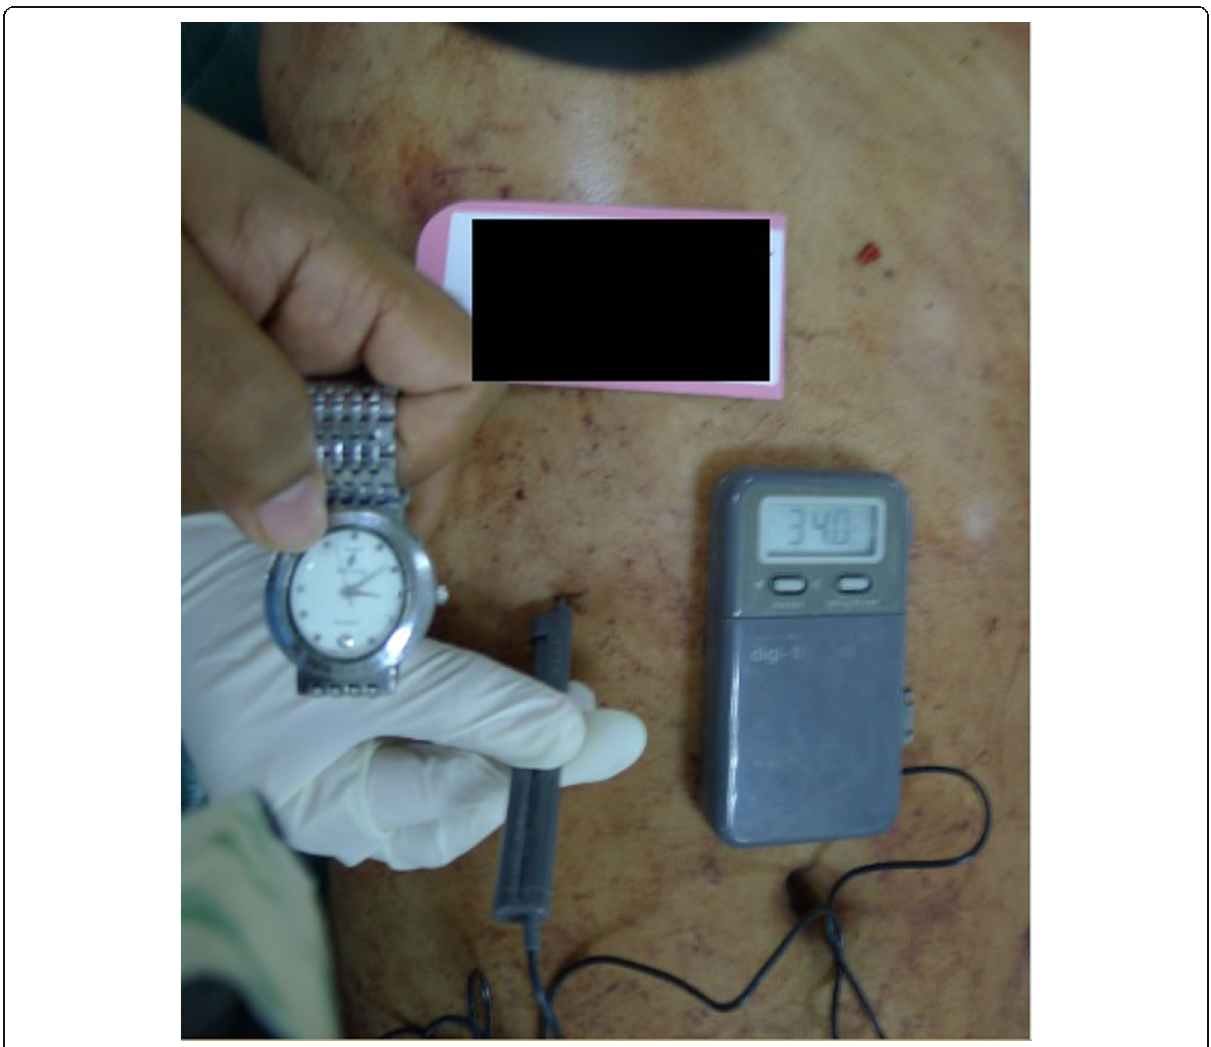
Fig. 4 The subhepatic temperature taken 6 h after death revealed a warm body with a temperature of 34 °C, suggestive of possible hyperpyrexia around the time of